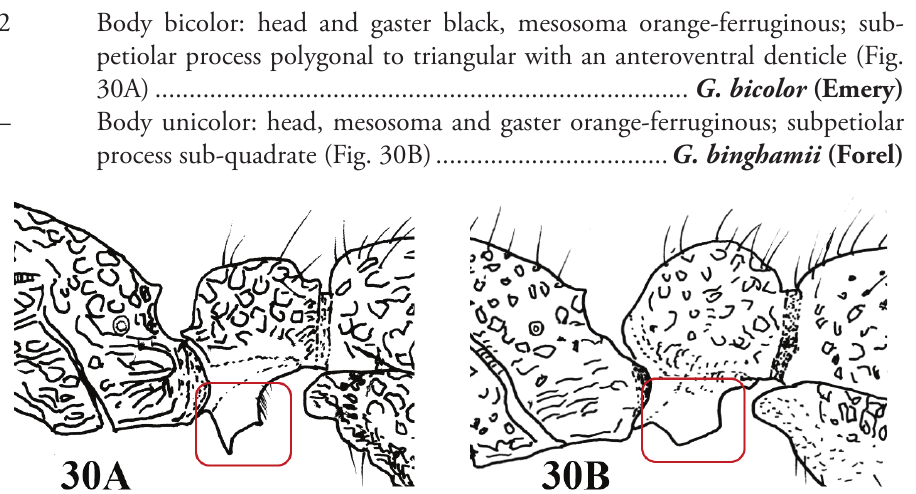
Figure 29. A G. binghamii worker B G. taivanensis worker.